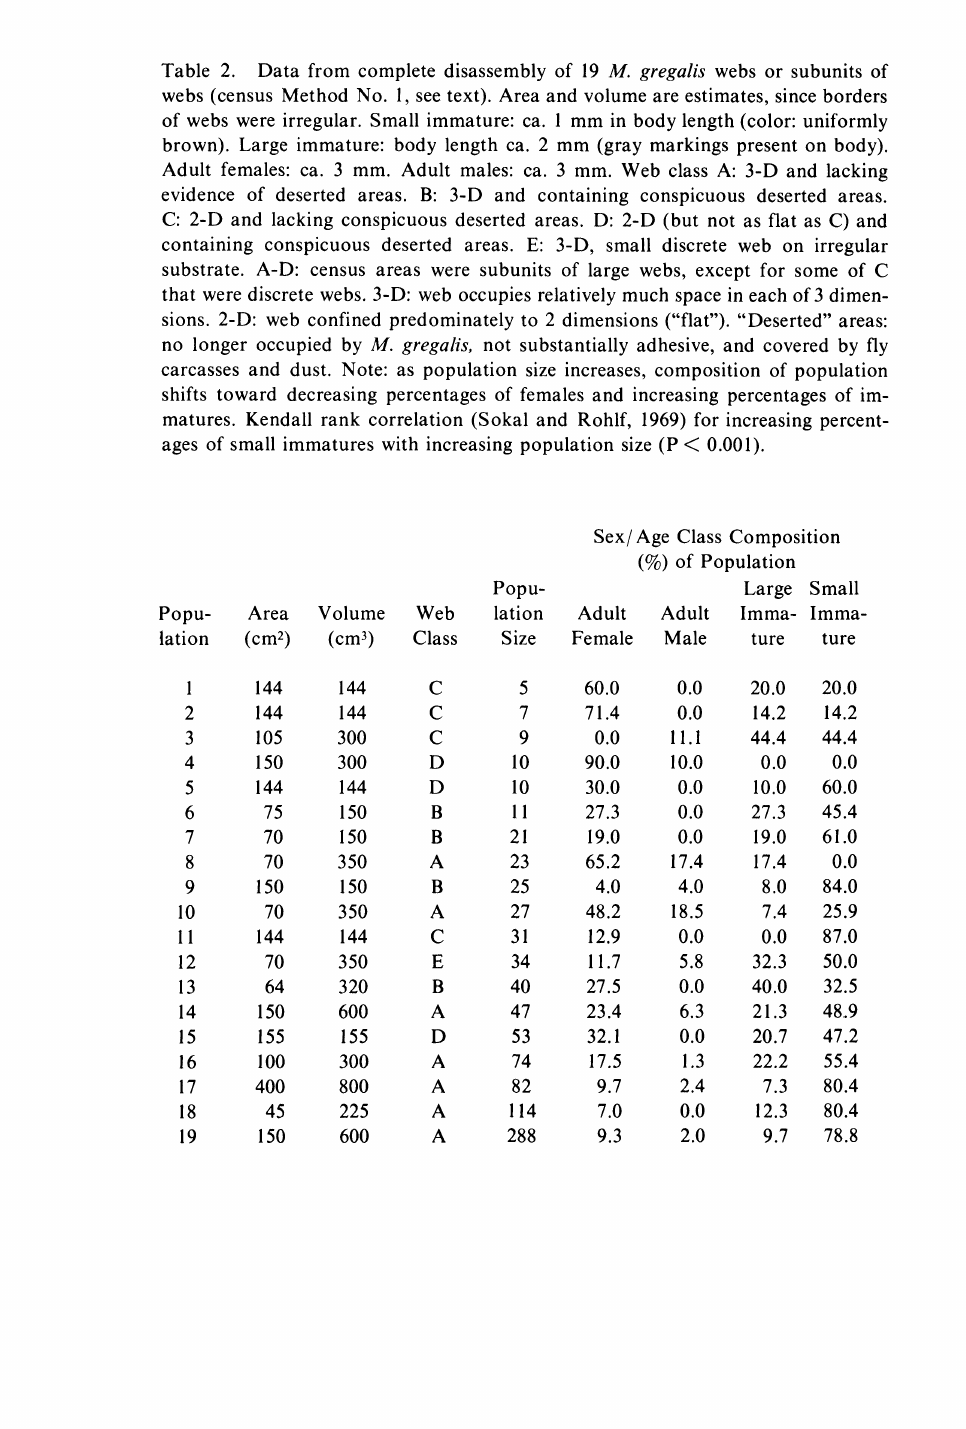
Table 2. Data from complete disassembly of 19 M. gregalis webs or subunits of webs (census Method No. 1, see text). Area and volume are estimates, since borders of webs were irregular. Small immature: